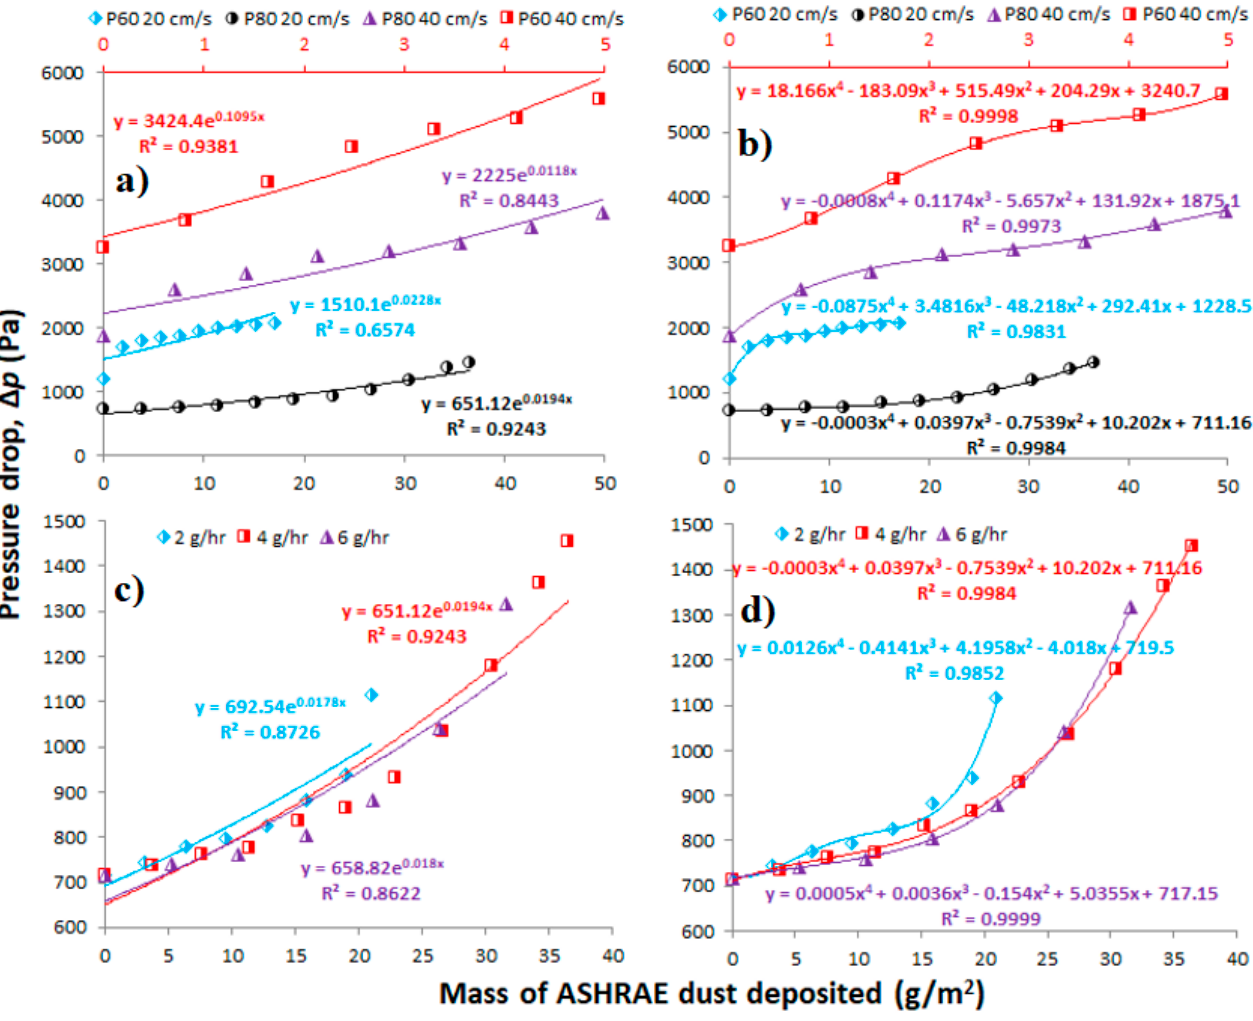
Figure 4. Dust loading curves fitted with different models: ( a ) various membranes and velocities at a constant loading rate of 4 g/h with exponential fit (the minor x -axis in red is for P60, at 40 cm/s), ( b ) the same fitted with 4th order polynomial (the minor x -axis in red is for P60, at 40 cm/s), ( c ) P80 membrane at 20 cm/s at different loading rates with exponential fit, ( d ) the same fitted with 4th order polynomial.